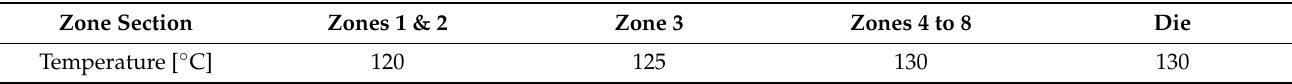
Table 1. List of temperature profiles used in twin-screw